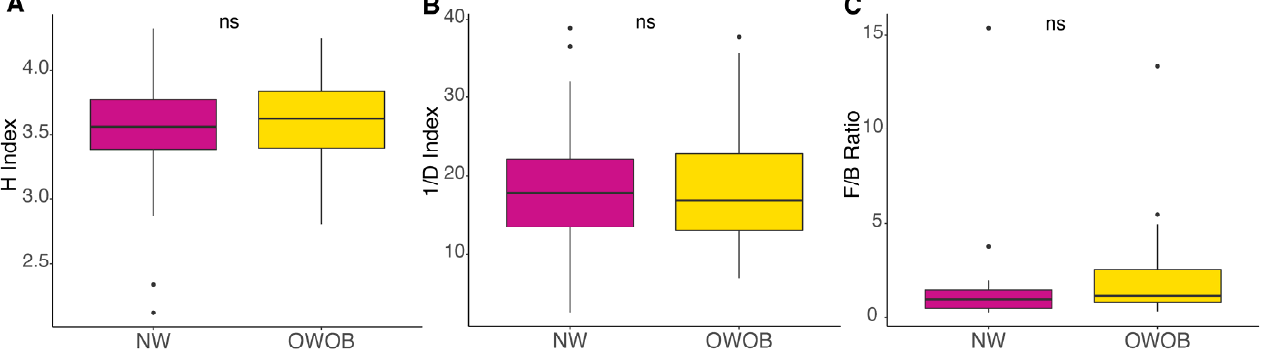
Figure 2. Alpha diversity, ( A ) Shannon Index (H), ( B ) Inversed Simpson diversity Index (1/D), and ( C ) Firmicutes-to-Bacteroidetes ratio (F/B) of normal-weight and obese-overweight groups. NW group is shown in magenta color and OWO in yellow. ns: p > 0.05. Pairwise comparisons were obtained using WRST and t -test.